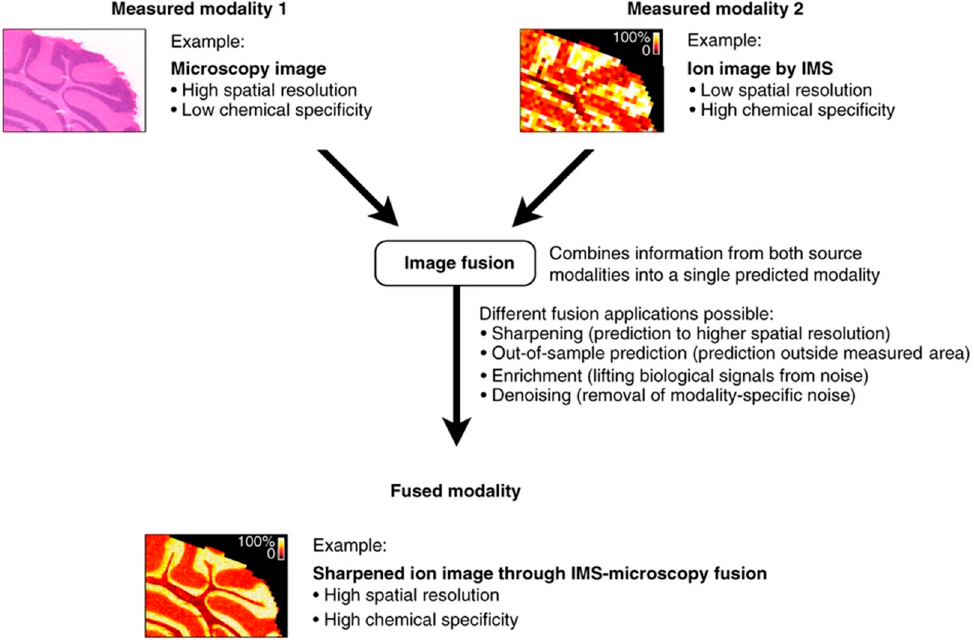
Figure 7. Fusion of microscopy and imaging mass spectrometry (IMS) to deliver microscopy’s spatial resolution and chemical specificity of IMS, that is combining two different modalities to make more accurate decision as single predicted modality. Reprinted with permission from reference [51], 2015, Springer Nature.